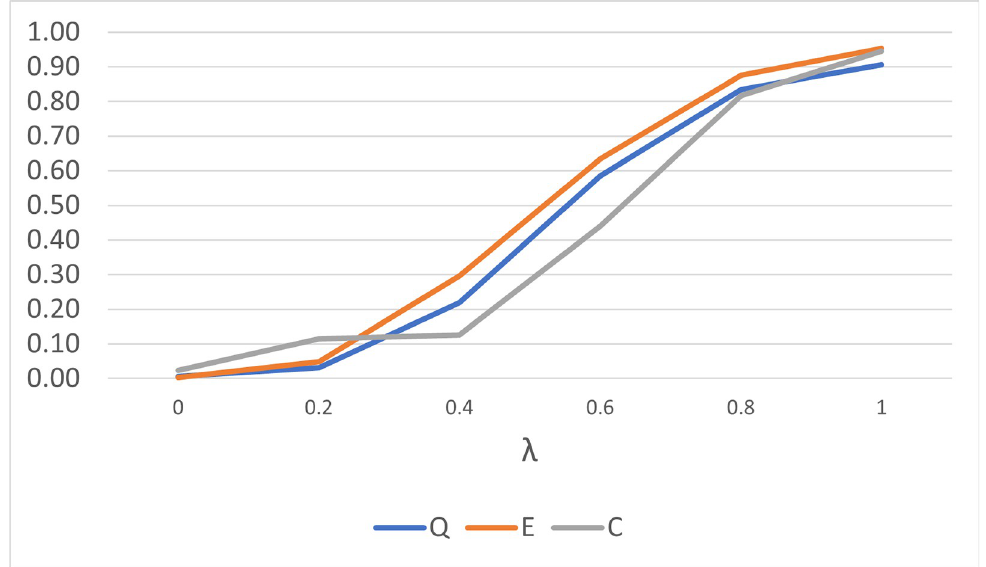
Fig 3. The performance of the Q k , E k and C k statistics for n = 10 and κ = 3, for a patch of three outliers.